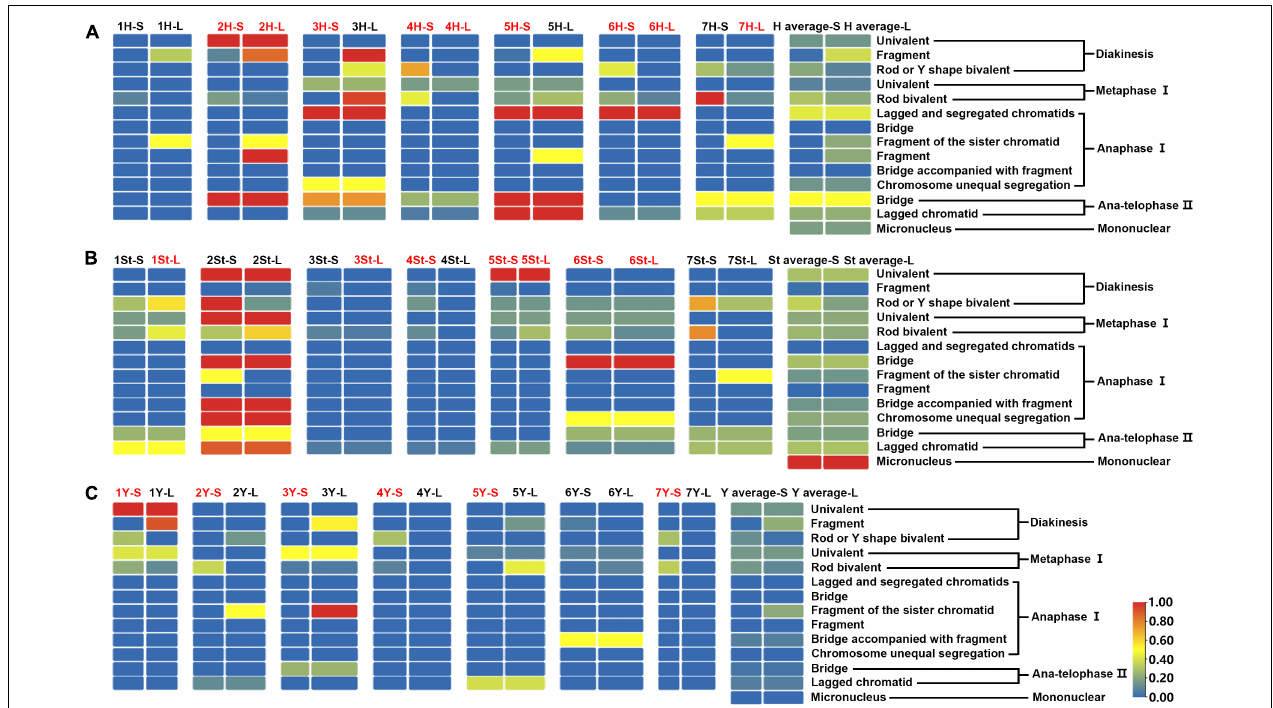
FIGURE 7 | Heatmap generated by TBtools showing the types and frequencies of the abnormality chromosomes. The scale bars represent the relative frequencies of the abnormality chromosomes. The arms with the red name represent heterozygosity, and the black represents homozygosity. The complete heatmap is divided into three parts (A–C) by genome for demonstration purposes.